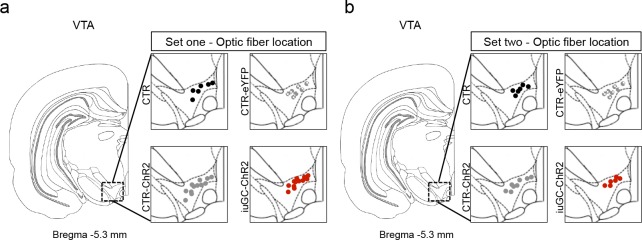
Optic fiber placement of animals used for behavioral experiments.Schematic representation of optic fiber placement in LDT terminals in the VTA of the first (a) and second (b) set of rats that performed behavioral experiments.